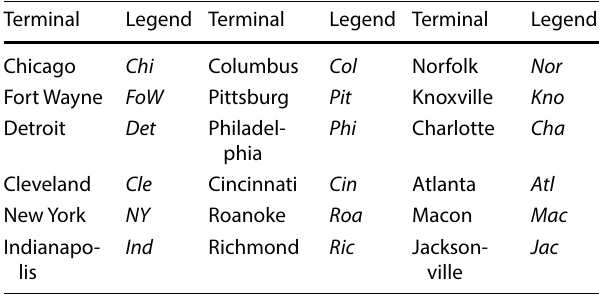
Table 1 Terminal